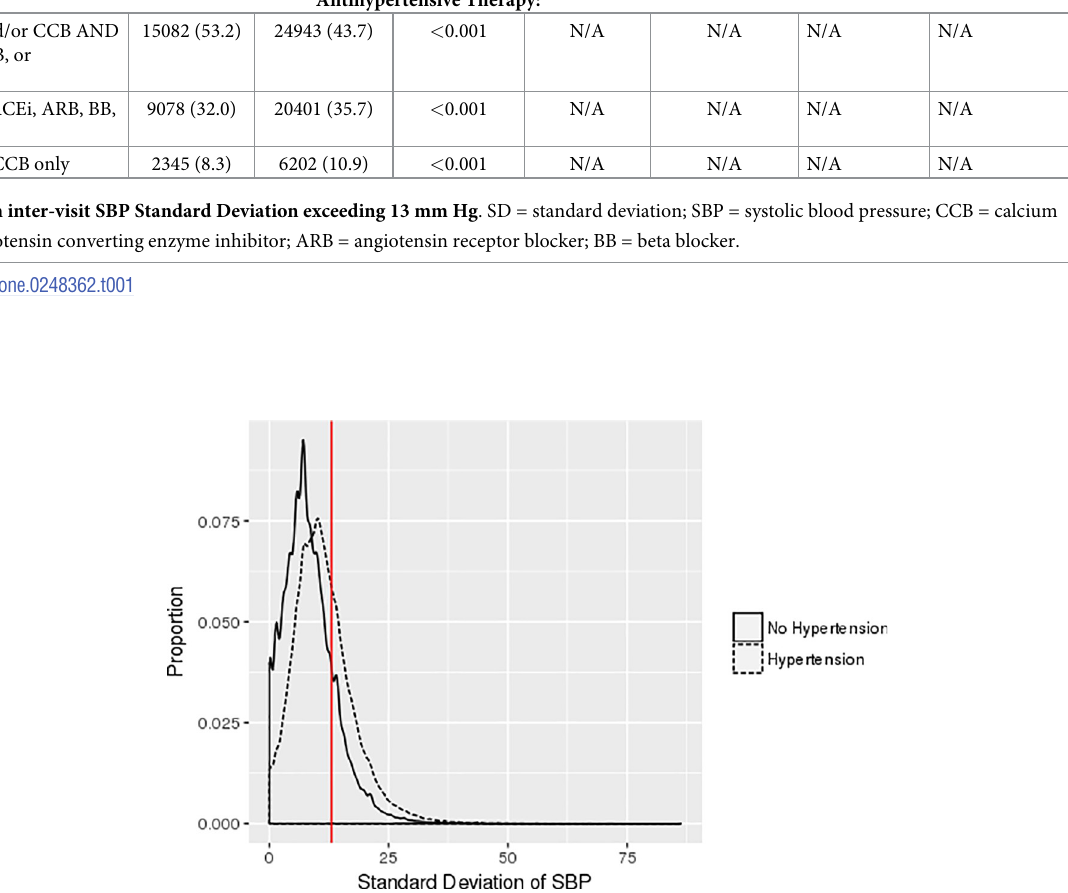
Patients with Hypertension (n = 85,455)